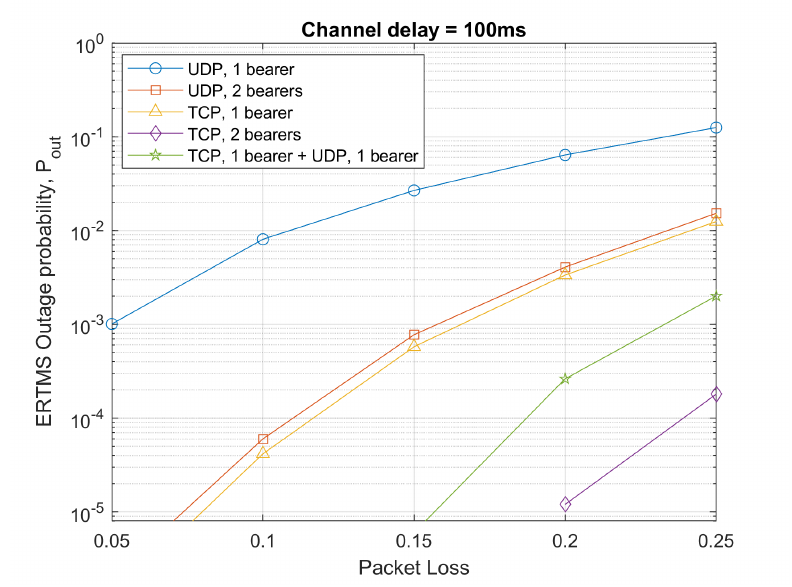
Figure 12. PR/MA over-limit outage vs. network packet losses for a delay of 100 ms.